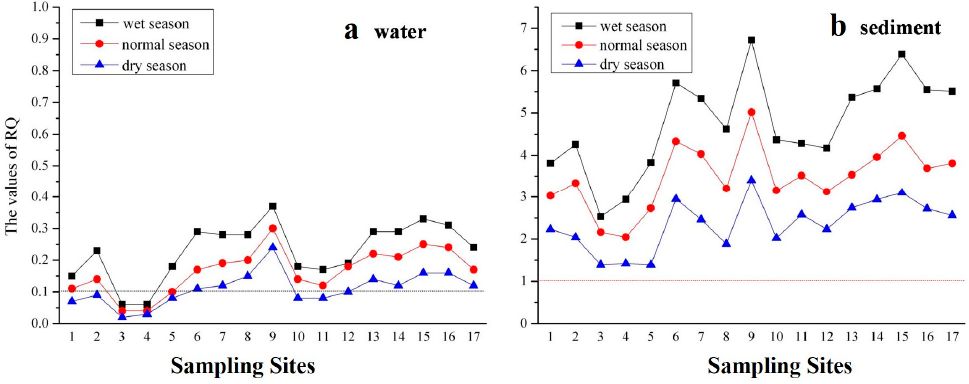
Figure 6. Total risk quotient (RQ) values of five phenolic compounds in 17 sampling sites in water ( a ) and sediment ( b ).